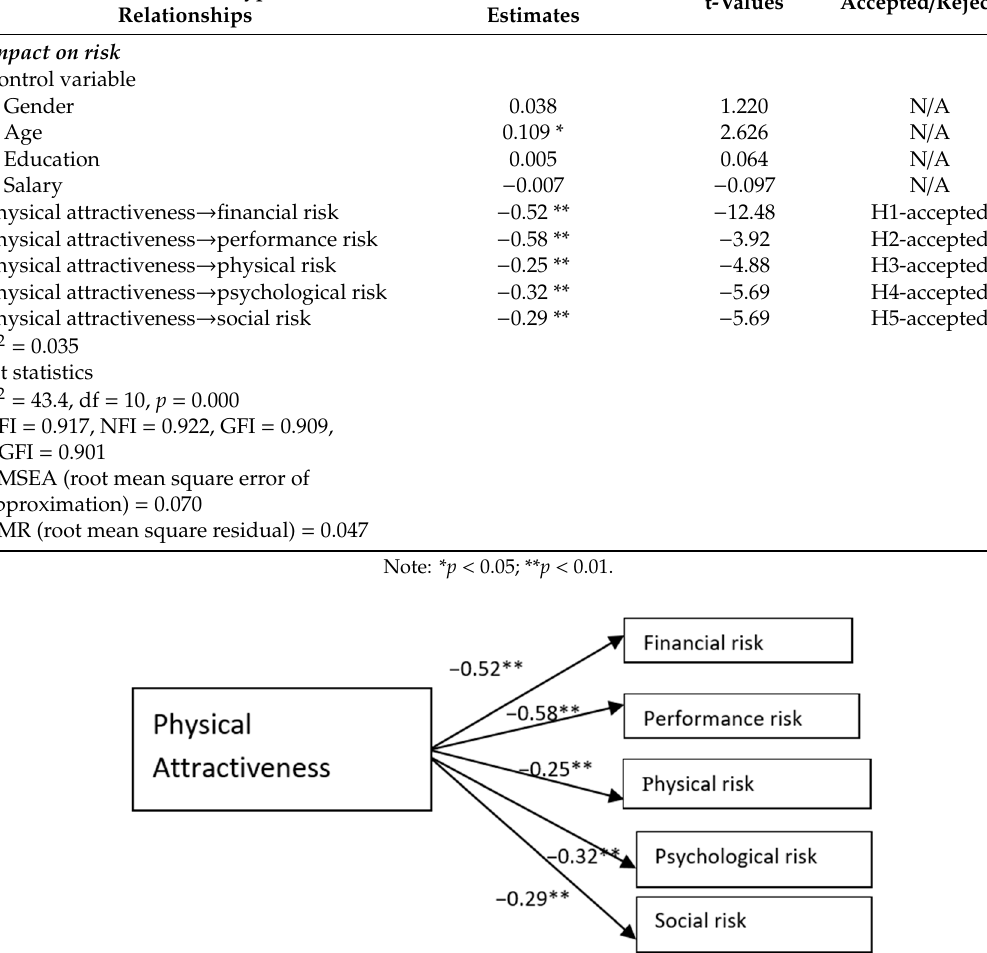
Figure 1. Hypothesized model. ** p < 0.01.